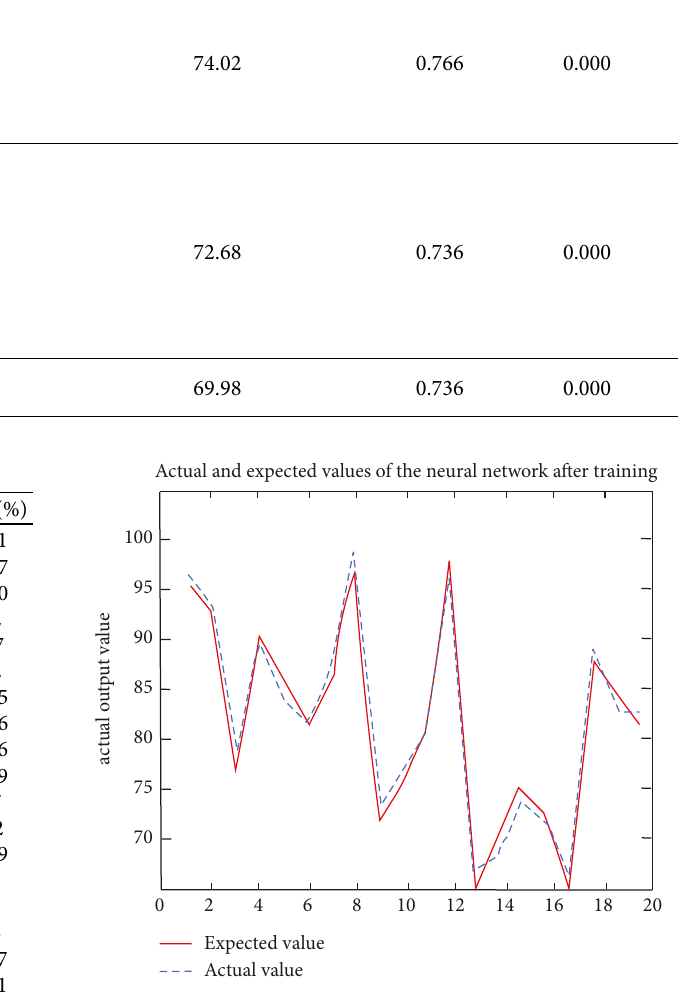
Figure 5: Comparison of the real value and the expected value predicted by the neural